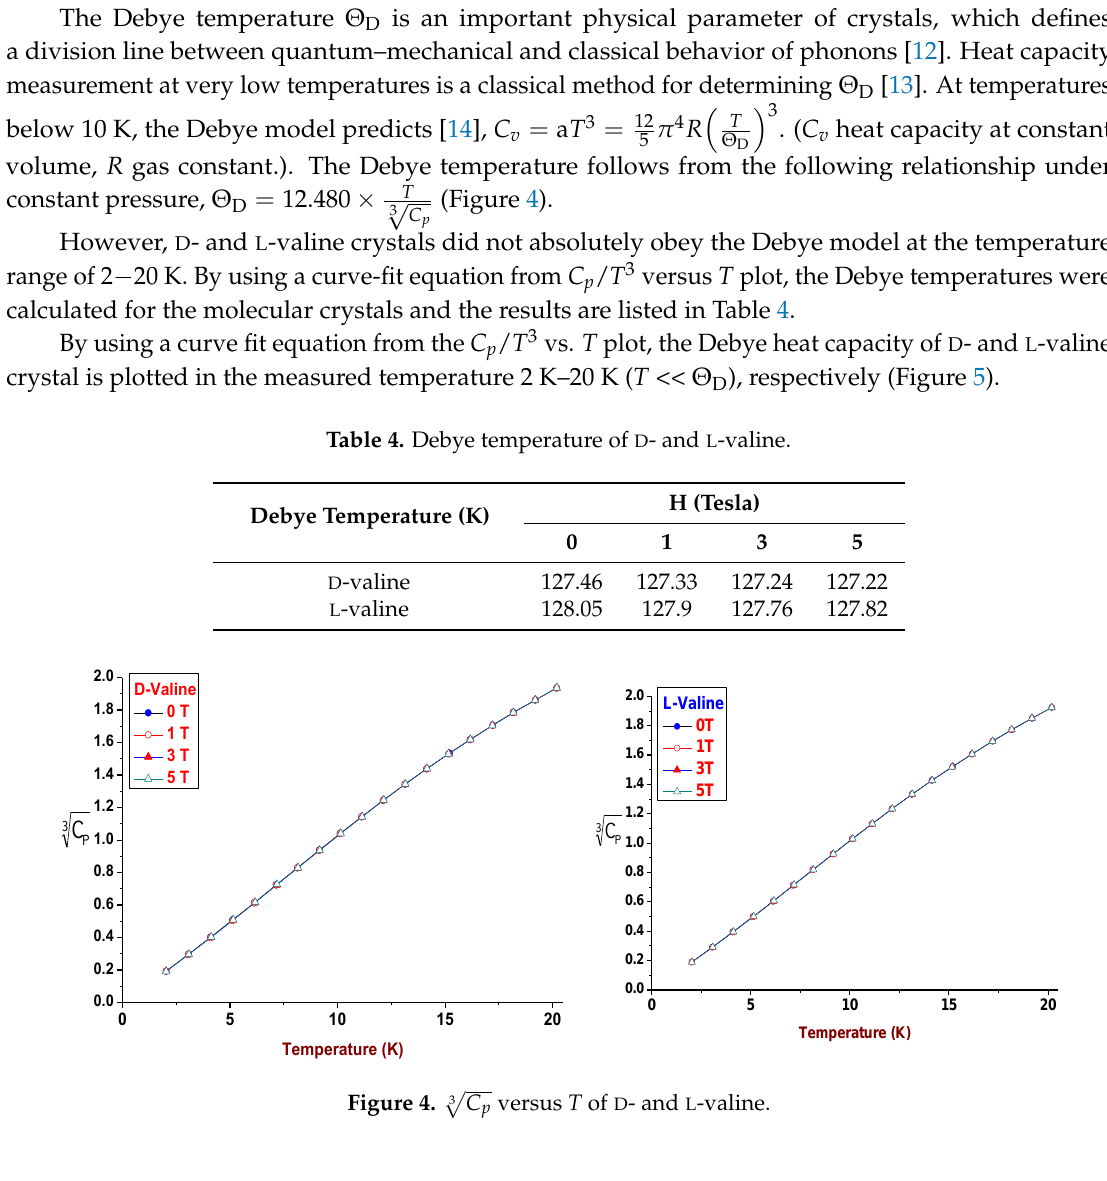
T √ (Figure 4). 3 C p